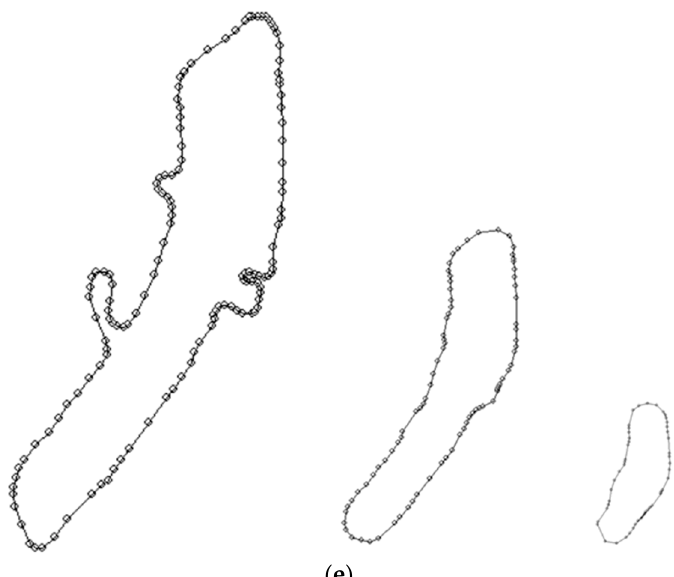
Figure 7. ( a ) Area limited by a polygon, number of vertices—141; ( b ) Area limited by a polygon, number of vertices—89, radius of generalization (modal value × MSCF )—25 × 1.6 = 40 m. ( c ) Area limited by a polygon, number of vertices—58, radius of generalization (modal value × MSCF )—44 m × 1.6 =70 m. ( d ) Area limited by a polygon, number of vertices—29, radius of generalization (modal value × MSCF )—74 m × 1.75 = 130 m. ( e ) Generalization results presented in approximate map scales: